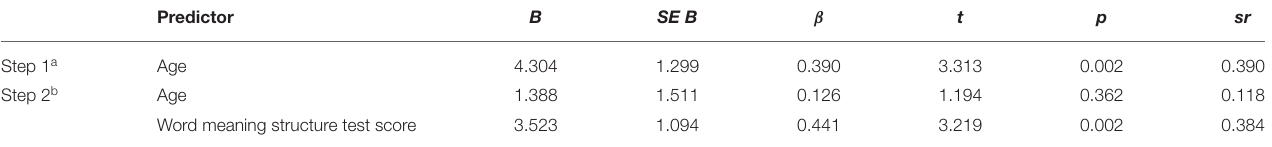
TABLE 4 | Predicting the number of accurate answers in children’s answers in response to free recall ( N = 63). Predictor